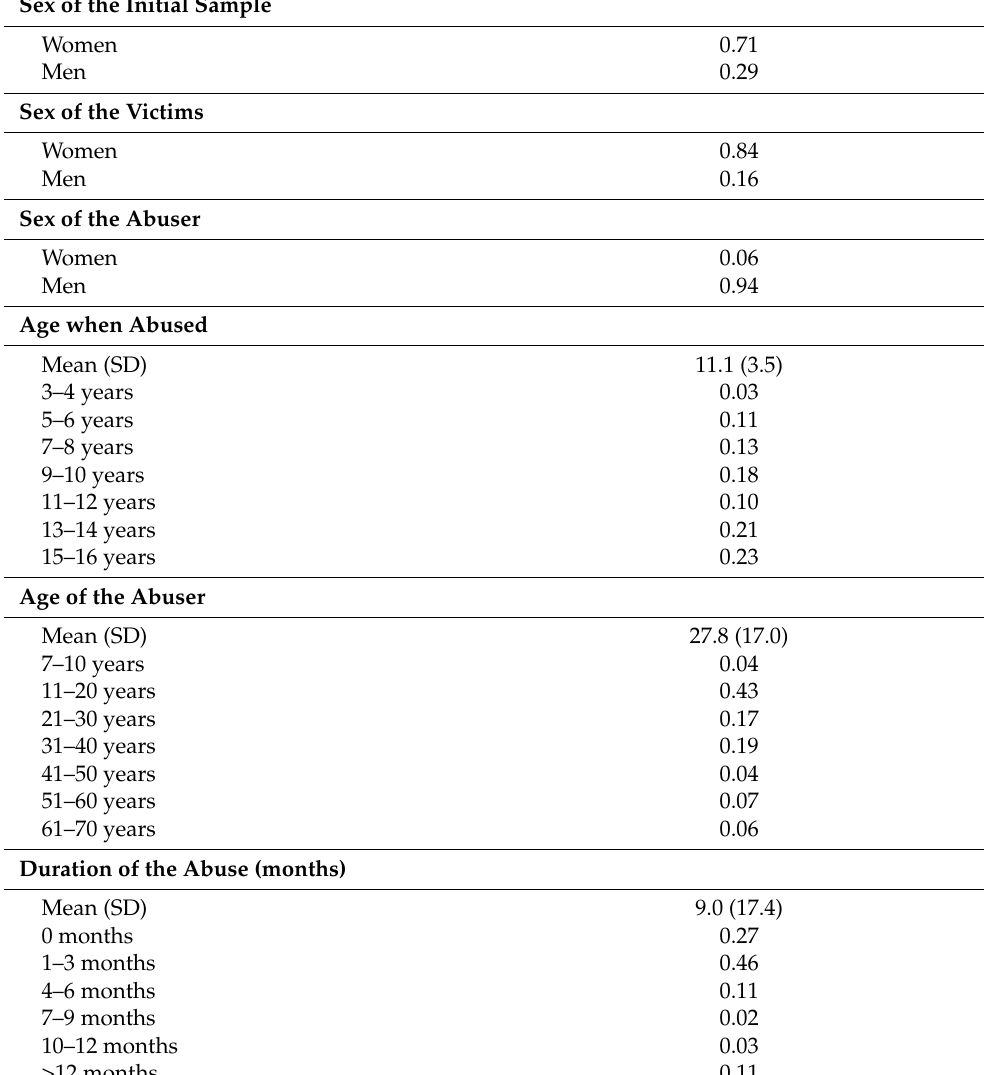
Table 1. Characteristics of sample, victims, abusers, and